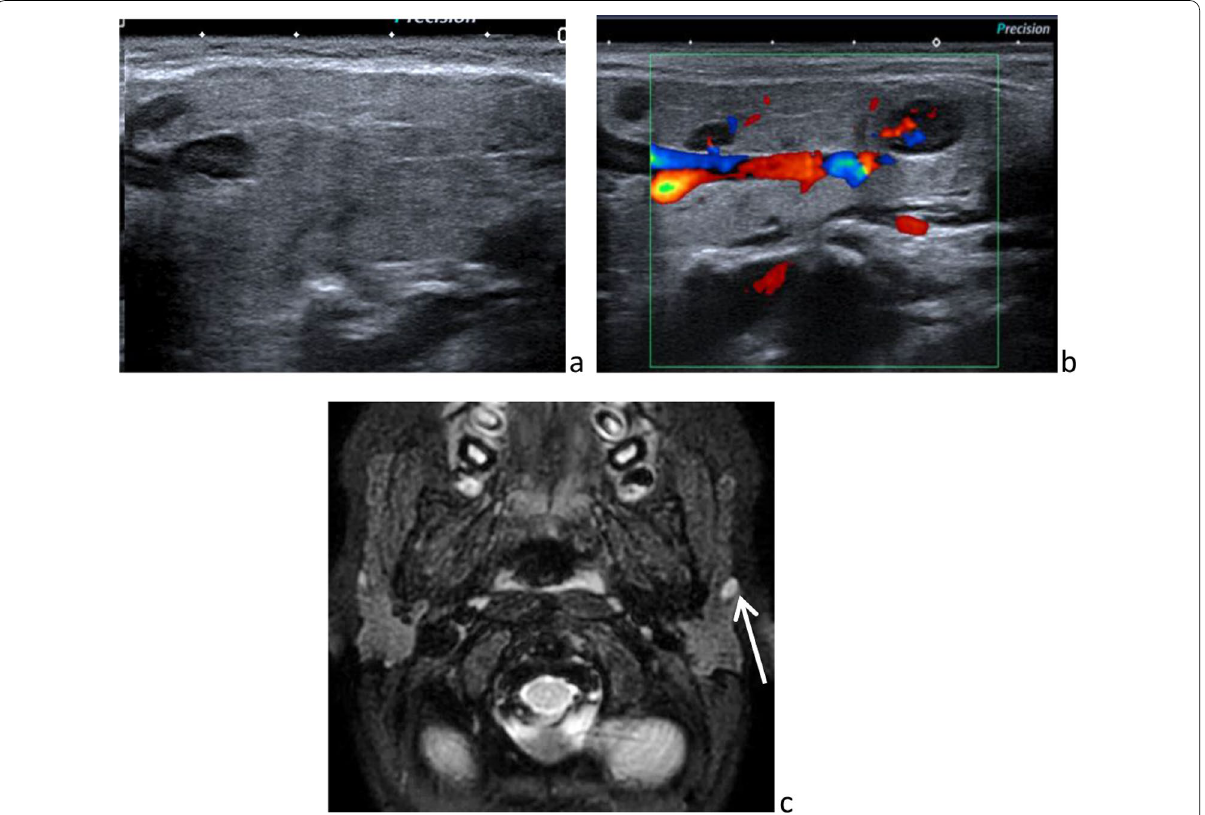
Fig. 1 Intraparotid normal lymph nodes on sonography ( a ), color‑Doppler sonography ( b ) and axial fat sat T 2 ‑weighted image ( c